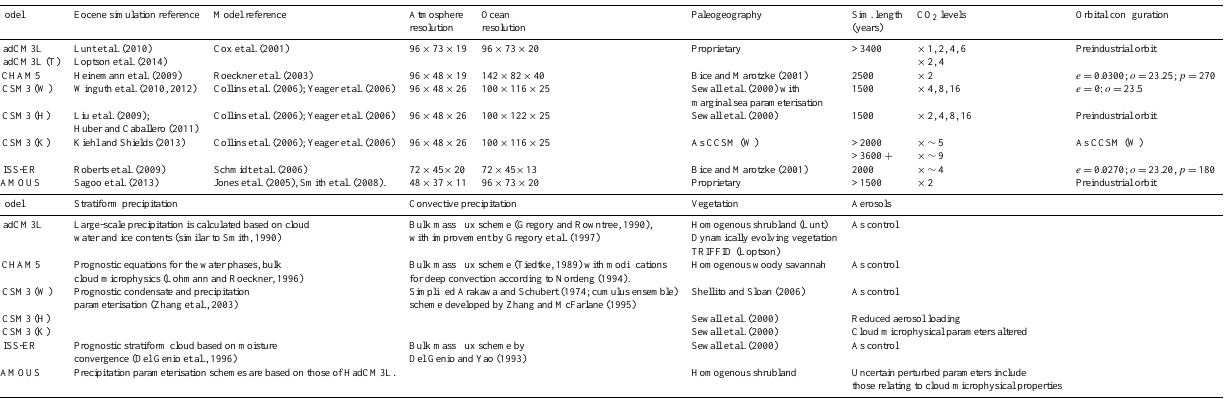
Table 1. Summary of model simulations in the ensemble adapted from Table 1 of Lunt et al. (2012). Additions detailing precipitation schemes are from Table 2 of Dai (2006). Some models have irregular grids in the atmosphere and/or ocean or have spectral atmospheres. The atmospheric and ocean resolution is given as X × Y × Z , where X is the effective number of grid boxes in the zonal, Y in the meridional, and Z in the vertical. e : eccentricity; o : obliquity; p : longitude of